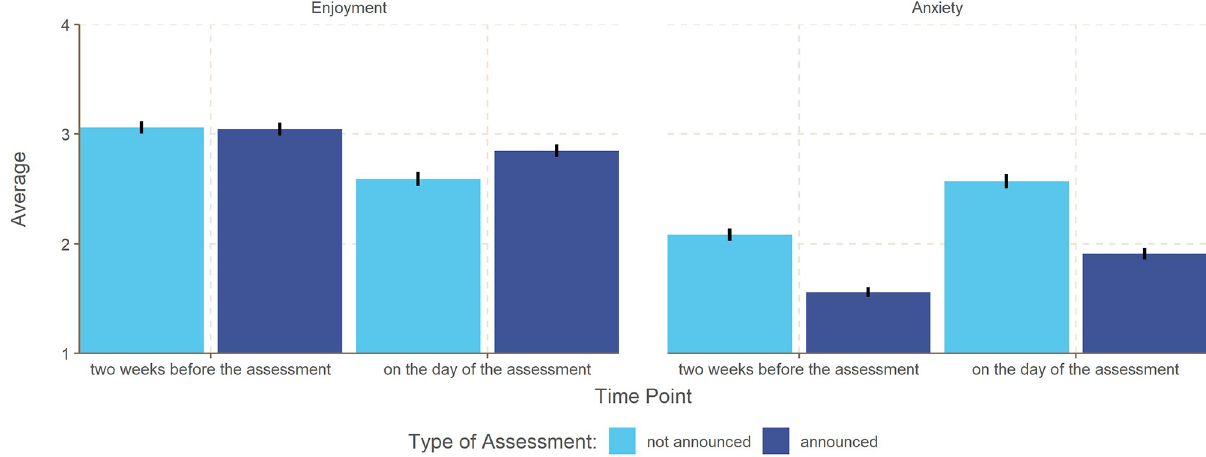
Fig 1. Average enjoyment and anxiety as a function of the type of assessment and the time point. Error bars represent 95% confidence intervals. Response scales for enjoyment and anxiety: 1 = strongly disagree to 4 = strongly agree .